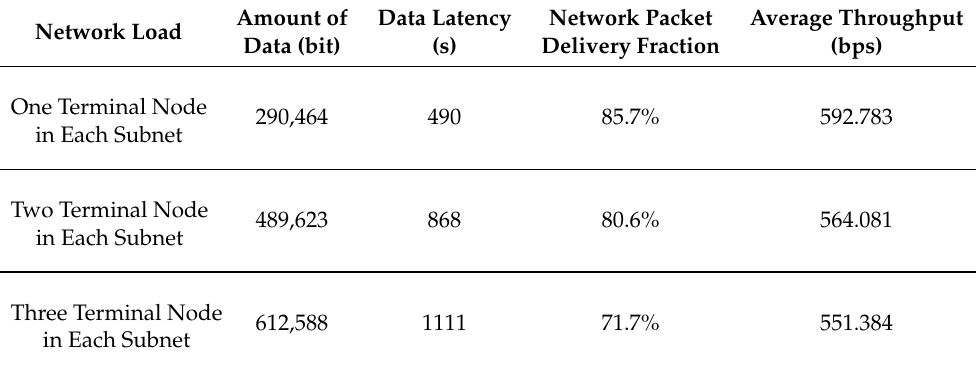
Table 3. Throughput test results under different network load conditions.